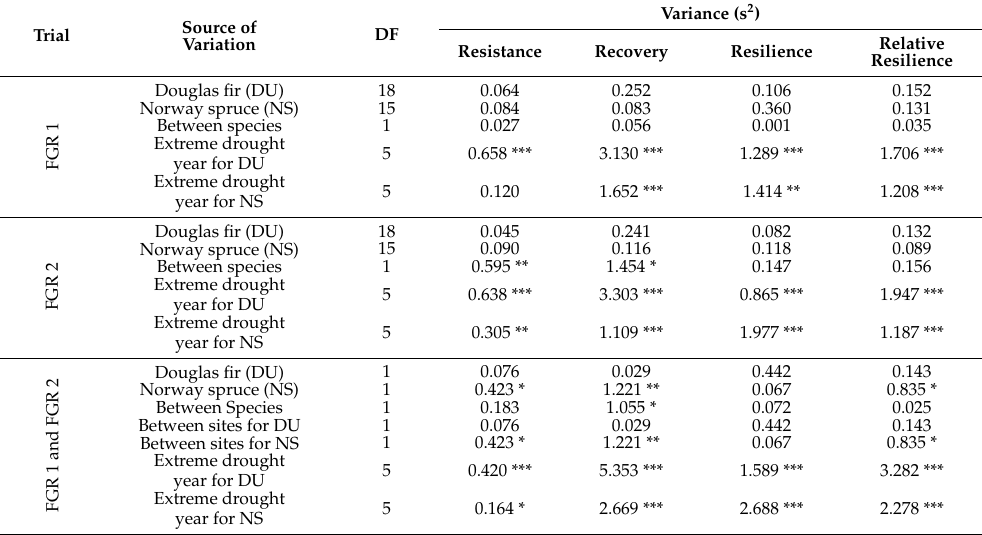
Table 4. Analysis of variance of Douglas fir and Norway spruce drought parameters for years of extreme drought.